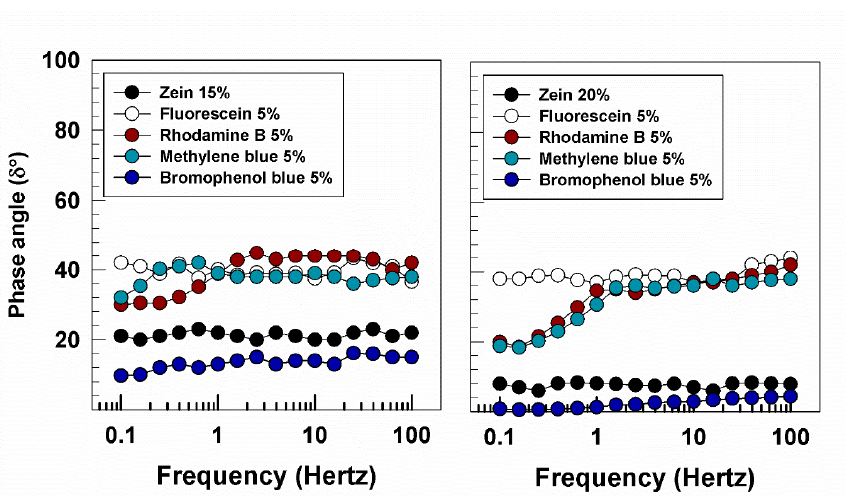
Figure 10. Phase angle of zein gels containing 5% of compounds characterized by different physico-chemical properties.